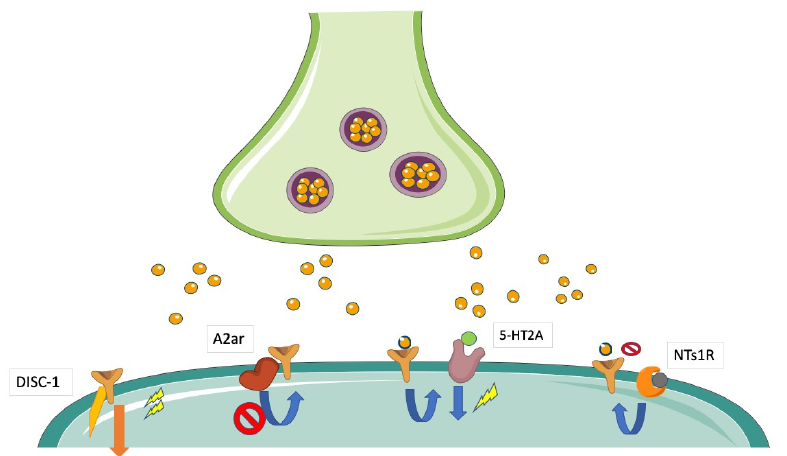
Figure 5. Modulation of D2R-mediated signaling by heterodimerization or intracellular cross-talk. D2Rs may directly or indirectly interact with different transmembrane or intracellular partner pro- teins. These interactions are regarded to affect levels of downstream signaling and are supposed to modify the response to antipsychotic agents. The interaction with DISC-1 potentiates D2R-mediated signaling, whereas putative interactions with A2AR and NTs1R have been reported to decrease it. Moreover, there is evidence of a cross-talk between D2R and 5-HT2AR, which enhances D2R-mediated downstream signaling.